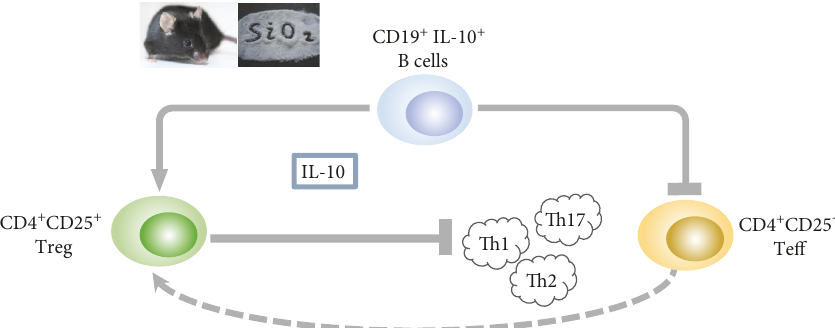
Figure 5: A schematic representation for the regulatory function of B10 on crystalline silica-induced Te ff /Treg in